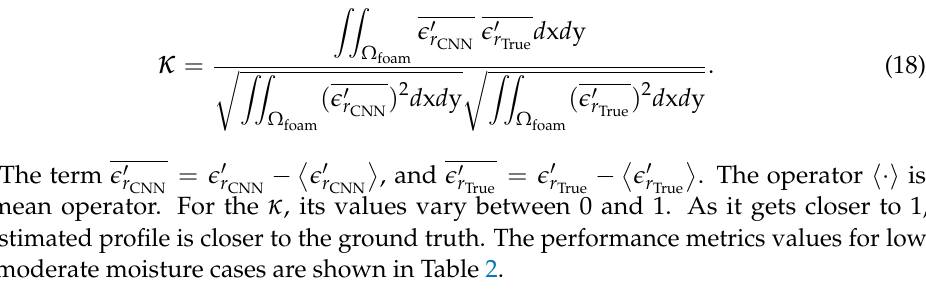
κ for low and moderate moisture Table 2.